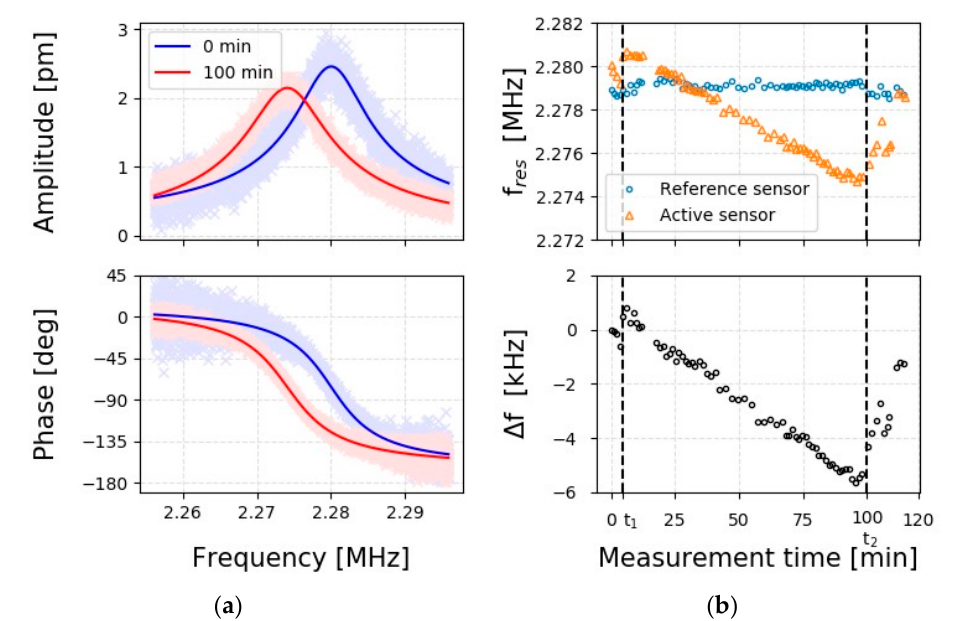
Figure 2. ( a ) Measured amplitude and phase response of the active element before and after the experiment. A least squares fit algorithm was applied to determine the resonance frequency (solid lines. The total resonance frequency shift is approximately 6 kHz. ( b ) Measured resonance frequency f res of the active sensor element and the passive reference which is used to compensate environmental effects. The coil current was turned on at t = t 1 and was stopped at t = t 2 . The bottom image shows the frequency shift relative to the reference